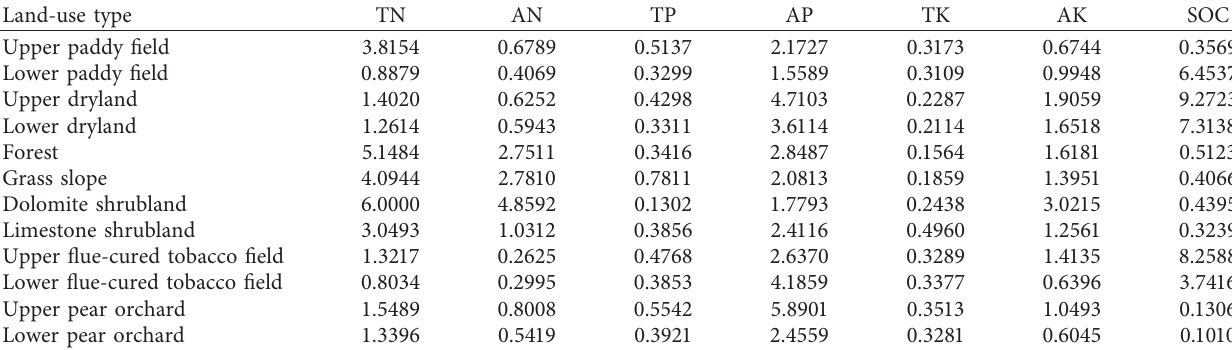
Table 2: Nondimensionalized results of soil nutrient contents under different land-use types.